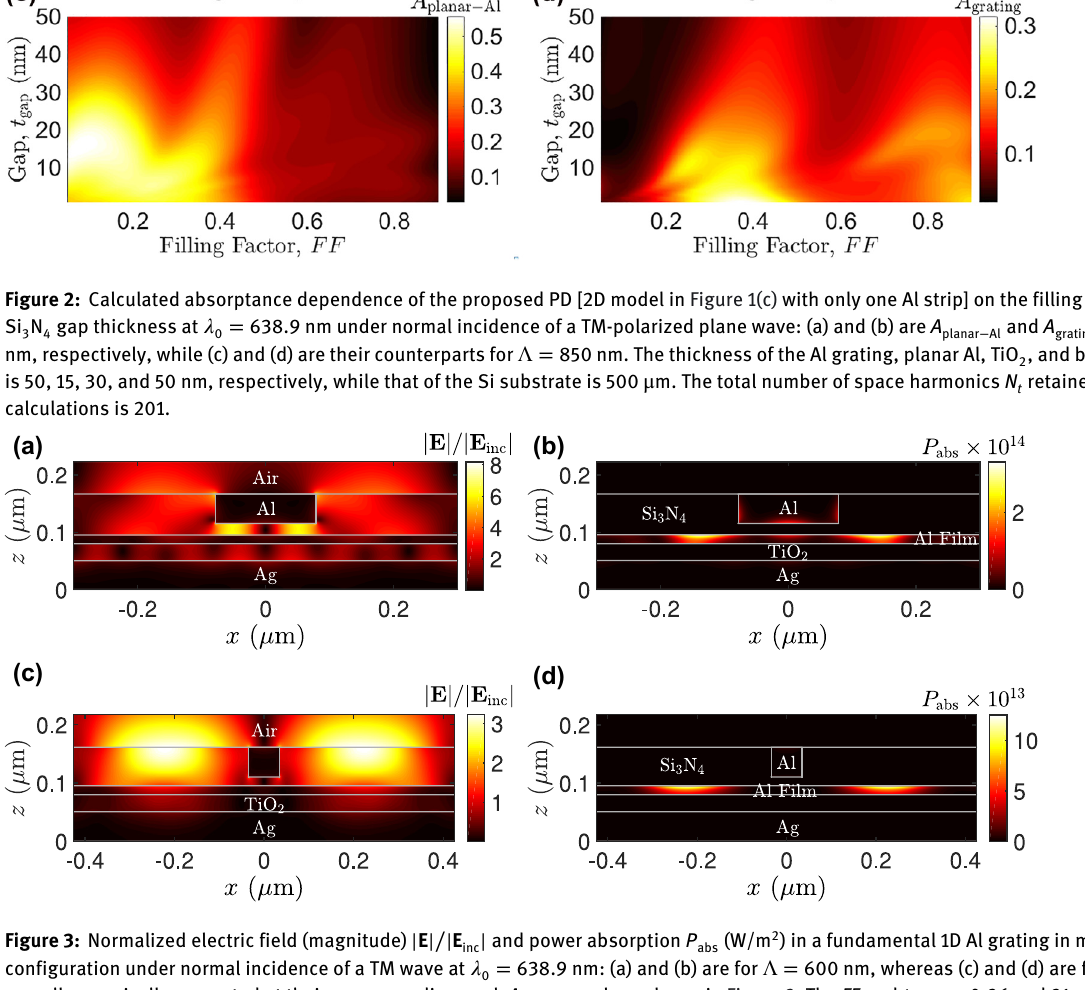
Figure 3: Normalized electric field (magnitude) | E | ∕ | E configuration under normal incidence of a TM wave at 𝜆 nm, all numerically computed at their corresponding peak A 16 nm) for Λ = 600 nm ( Λ = 850 nm),